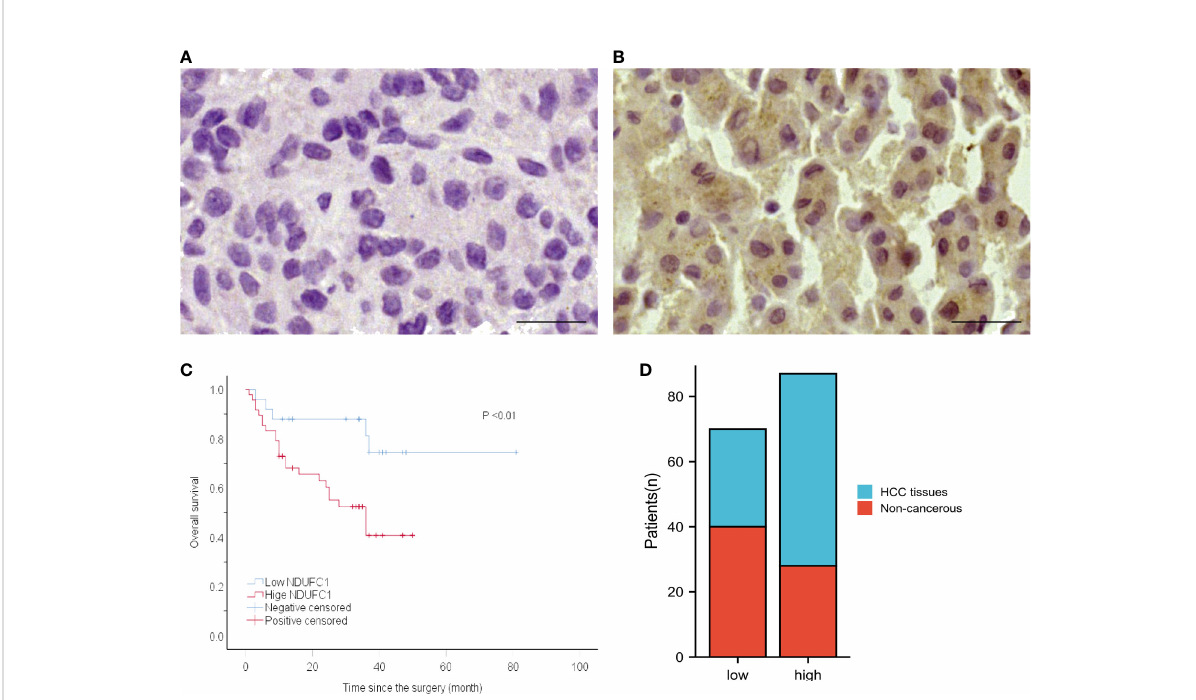
FIGURE 3 The protein expression of NDUFC1 in HCC specimens and non-cancerous tissues and the relationship between NDUFC1 expression and prognosis of patients with HCC. (A) NDUFC1 is negatively stained in non-cancerous tissue (left) and is positively stained in HCC specimen (right). (B) Kaplan – Meier survival curve shows that high NDUFC1 expression indicates a low over-all survival rate. Bar = 50 nm, (C) High level of NDUFC1 expression indicate poor prognosis. (D) NDUFC1 expression was higher in